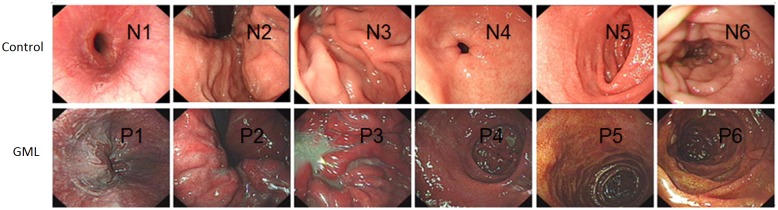
Endoscopic examination of the upper gastrointestinal tract.The upper gastrointestinal tract includes esophagus (N1/P1), cardia(N2/P2), gastric fundus(N3/P3), gastric antrum and body(N4/P4), the duodenal bulb (N5/P5) and descending portion(N6/P6). N stands for normal healthy subjects. P stands for polycythemia patients.